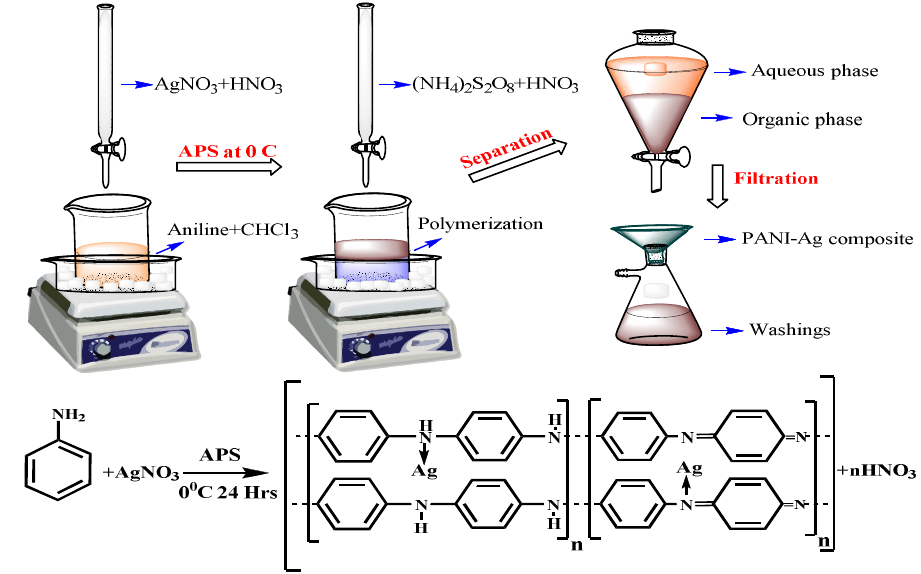
Figure 2. Flow chart for synthesis of the PANI-Ag composite.